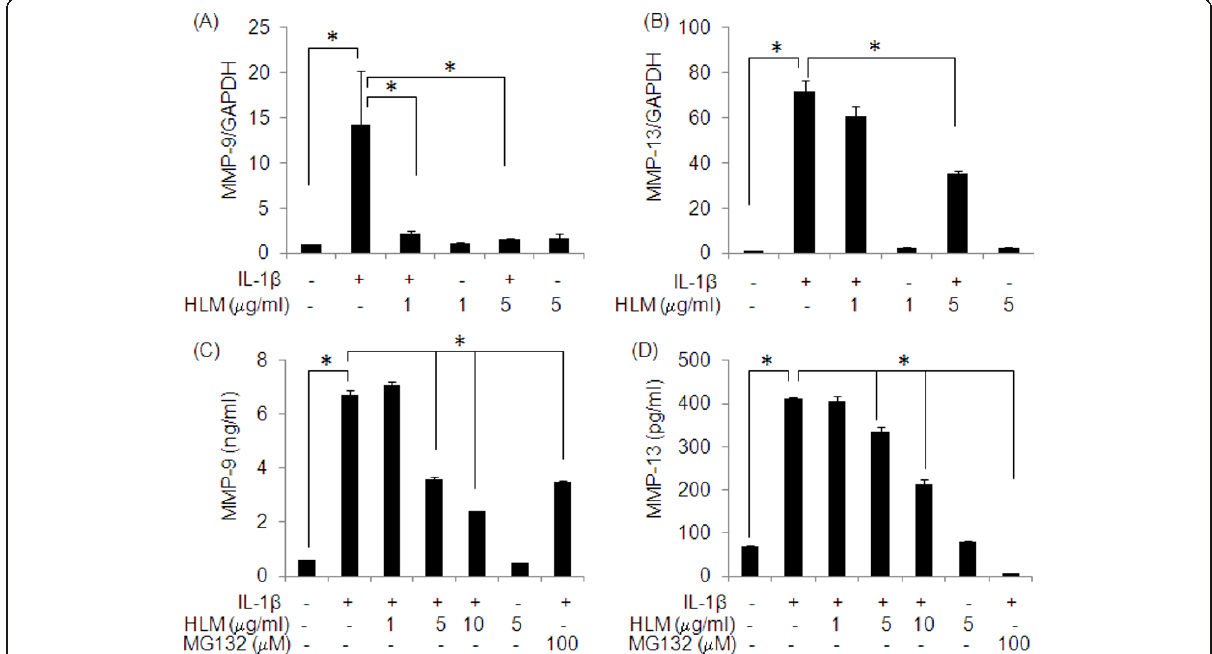
Figure 3 Effect of HLM ( Uncaria tomentosa ., Boswellia spp ., Lepidium meyenii and L-Leucine ) on the IL-1 b -induced expression of MMP-9 and MMP-13 in IL-1 b -stimulated OA chondrocytes . Chondrocytes were pretreated for 2 h with HLM (1-10 μ g/ml) and then stimulated or not stimulated with IL-1 b (5 ng/ml) for 6 h for MMP-9 mRNA (A) and 24 h for MMP-13 mRNA(B). mRNA expression was analyzed by Real time-PCR. Relative gene expression was normalized to GAPDH and compared with un-stimulated control. Levels of MMP-9 (C) and MMP-13 (D) in culture supernatants were quantified by sandwich ELISA at 24 h. Value represents Mean ± SD of three different experiments runs in duplicate. * p <